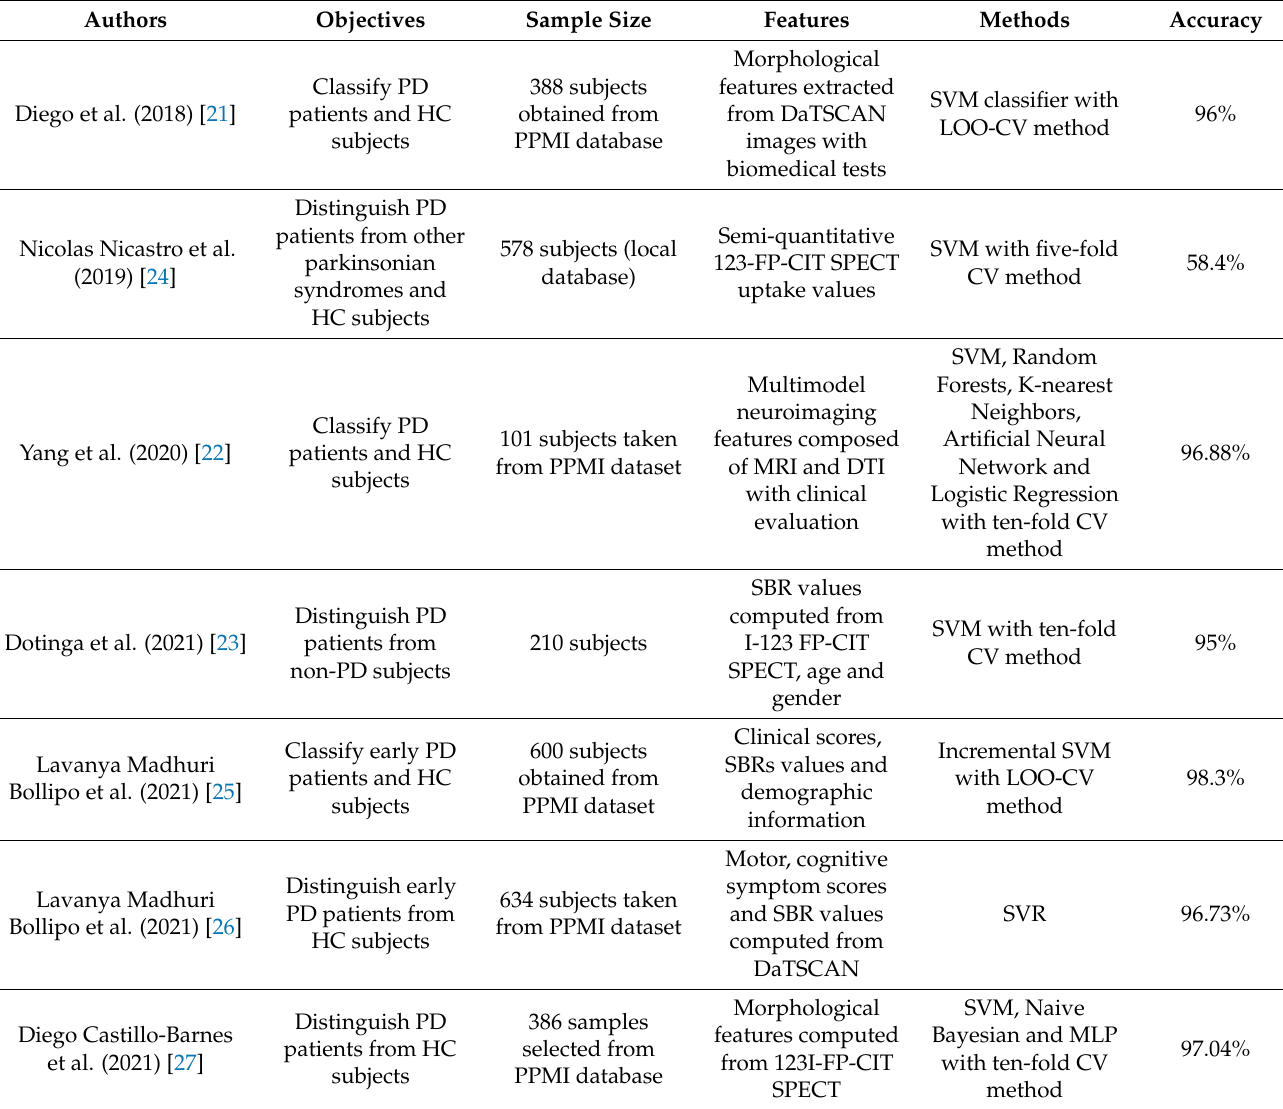
Table 1. Summary of existing classification approaches for PD